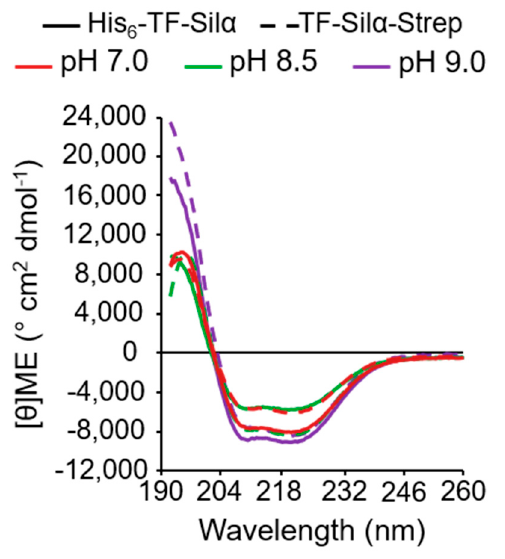
Figure 3. Circular dichroism spectra for His 6 -TF-Sila (solid line) and TF-Sil α -Strep (dashed line) at pH 7.0, 8.5 and 9.0, using the buffers noted in Table 3.